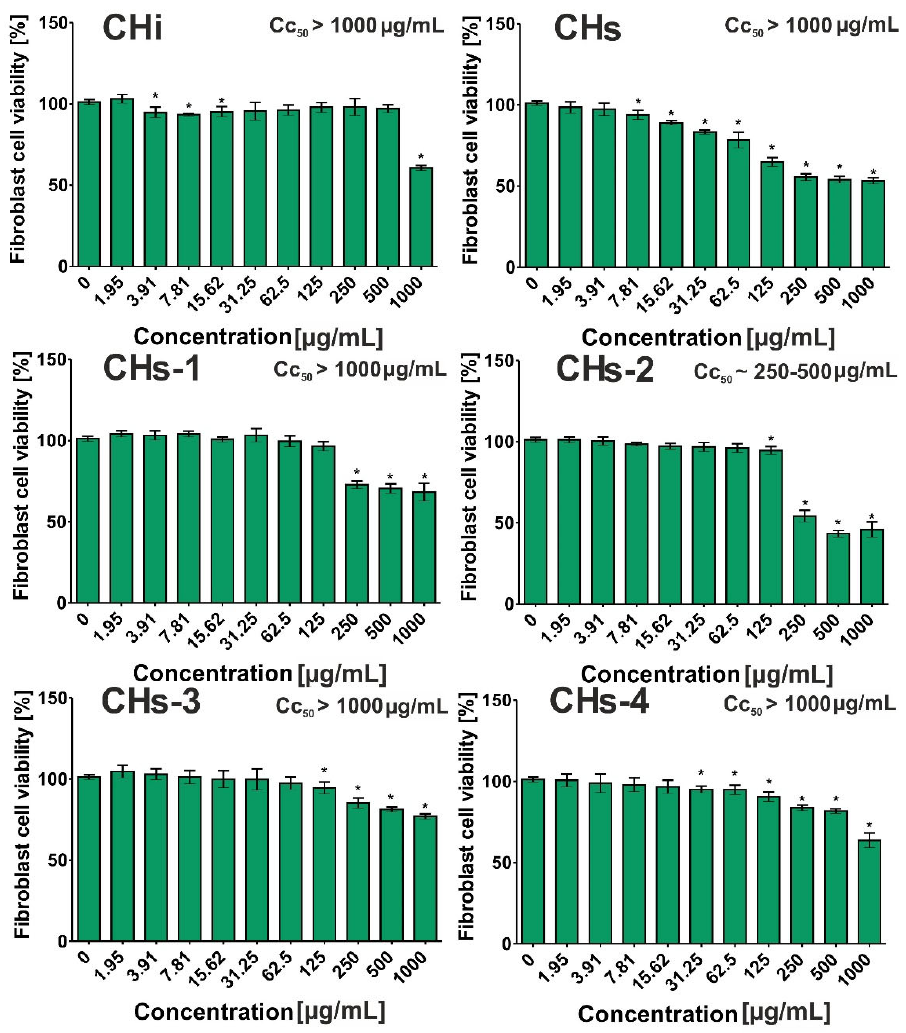
Figure 8. Cytotoxic effect of Cotoneaster extracts on human normal fibroblasts. (BJ cell line, ATCC CRL-2522TM). The cell viability was assessed after 24-h incubation using the MTT assay. Asterisk (*) denotes significantly different data ( p < 0.05, unpaired t ‐ test) compared to the control, namely culture medium without substances—0 μ g/mL.